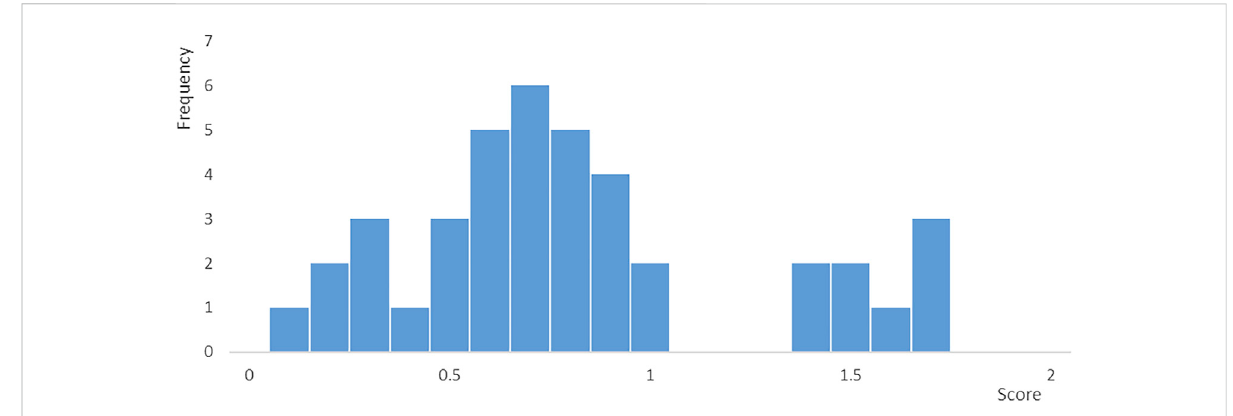
FIGURE 5 Score distribution of the dimension “ information base ”